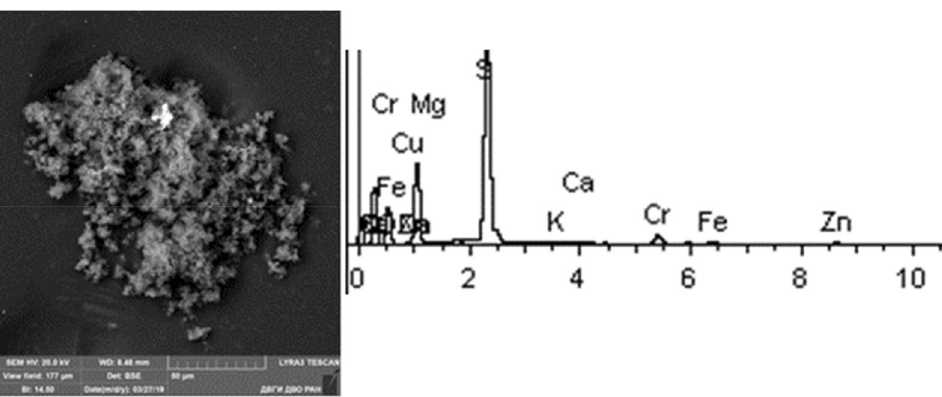
Figure 8. Chemical degreasing. Particles morphology. Scanning electronic microscopy. Measuring interval 50